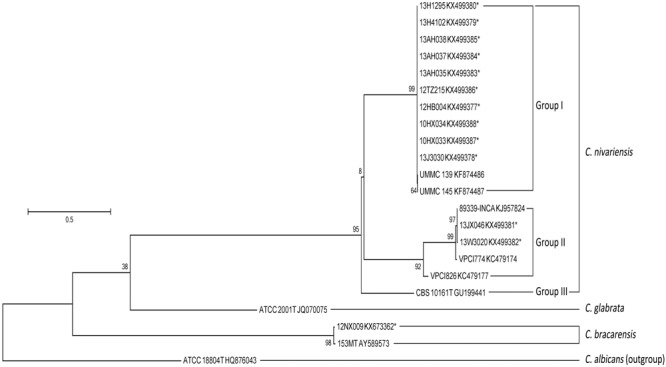
The maximum-likelihood tree of C. nivariensis and C. bracarensis with ITS sequences available in GenBank, using Candida albicans ATCC 18804 as an outgroup.